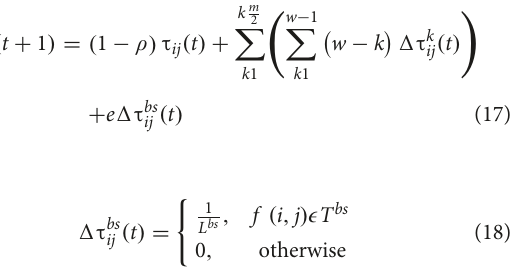
algorithm framework based on the probability